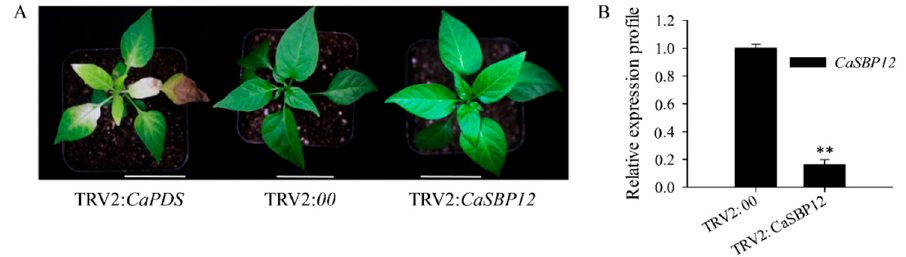
Figure 1. Phenotypes and silencing efficiency of CaSBP12 in silenced and control plants. ( A ) The phenotypes of CaSBP12-silenced plants. Photographs were taken 40 days post-infiltration. The white line is used as a scale bar (length 3.5 cm) (the diameter of the pot is 7 cm). ( B ) Silencing efficiency of CaSBP12 in CaSBP12-silenced plants. ** Represents significant differences at p ≤ 0.01. Mean values and SDs for three biological replicates are shown.